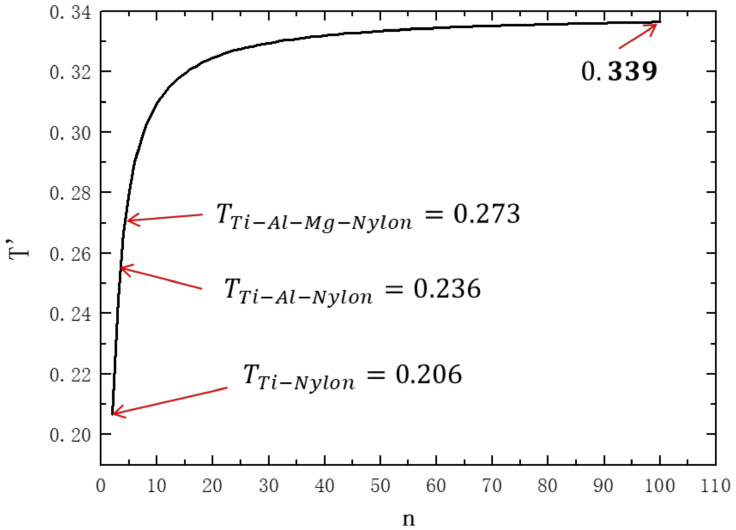
Figure 2. Variation trend of total transmission coefficient with gradient layer.